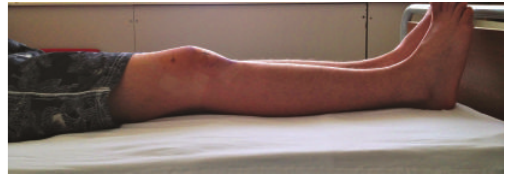
Figure 4: Postoperative examination of the patient with full exten-